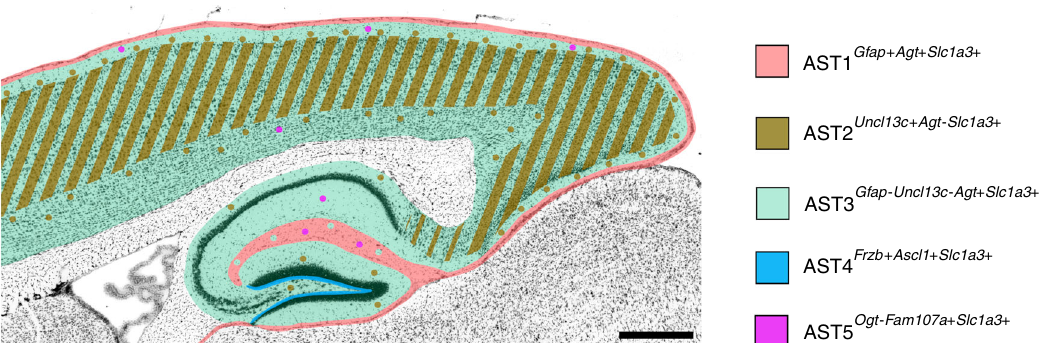
Fig. 7 Schematic summary of astrocyte subtype positions in adult mouse brain. Indicated positions are based on in situ hybridization data (Figs. 4 – 6) and are marked on a representative sagittal section of adult mouse brain (adapted from the Allen Mouse Brain Atlas). Subtypes are color-coded (as in Fig. 2a). Scale bar, 500 µ